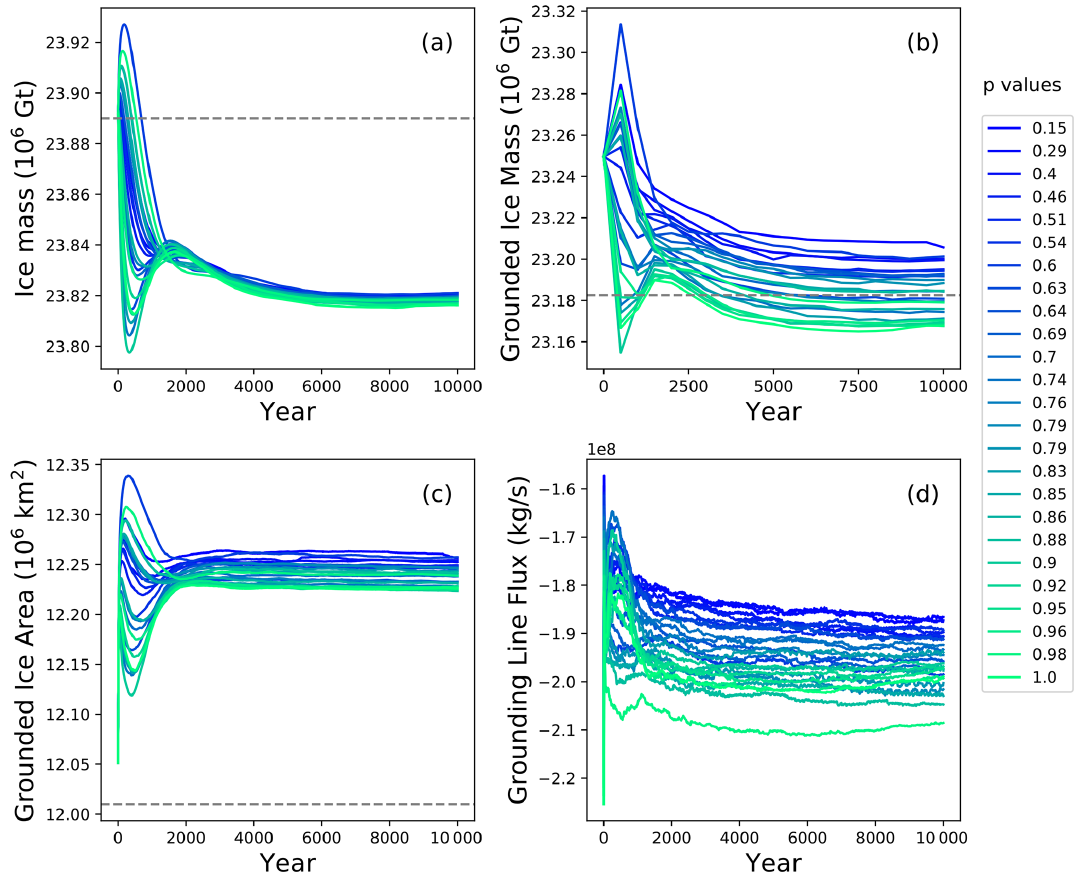
Figure 4. Time series for ice mass (a) , grounded ice mass (b) , grounded ice area (c) and grounding line flux (d) for the 25 spin-up ensemble members. Legend indicates the value of p for each ensemble member. Dashed gray lines indicate observational estimates, as calculated from the BedMachine Antarctica V2 data set (Morlighem et al., 2020). Note that the frequency of model output is sparser in panel (b) because it was derived using variables with less frequent